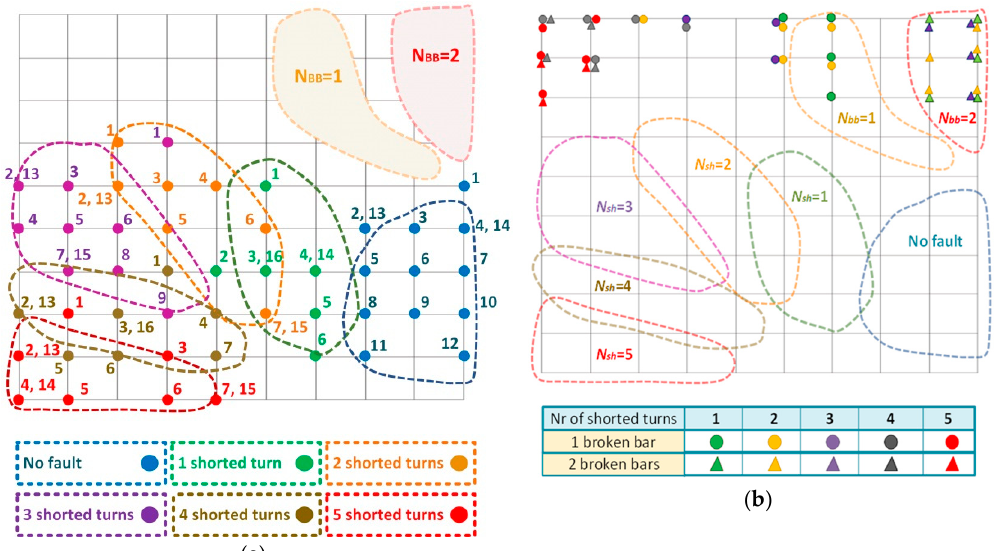
Figure 13. Classification of the induction motor failures: ( a ) stator windings faults: dotted lines—IM damage categories involved in the classification, hatched areas—IM damage categories not involved in the classification; ( b ) mixed faults: dotted lines—IM damage categories not involved in the classification; 10 × 10 SOM; N sh —number of shorted turns in the stator winding, N bb —number of broken rotor bars.